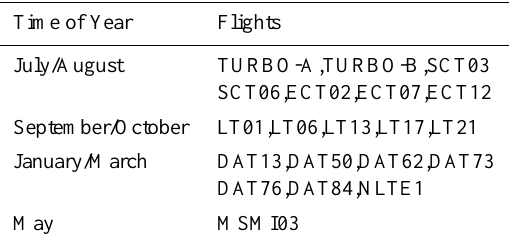
Table 4. Rocket flights used to derive mean seasonal density pro-